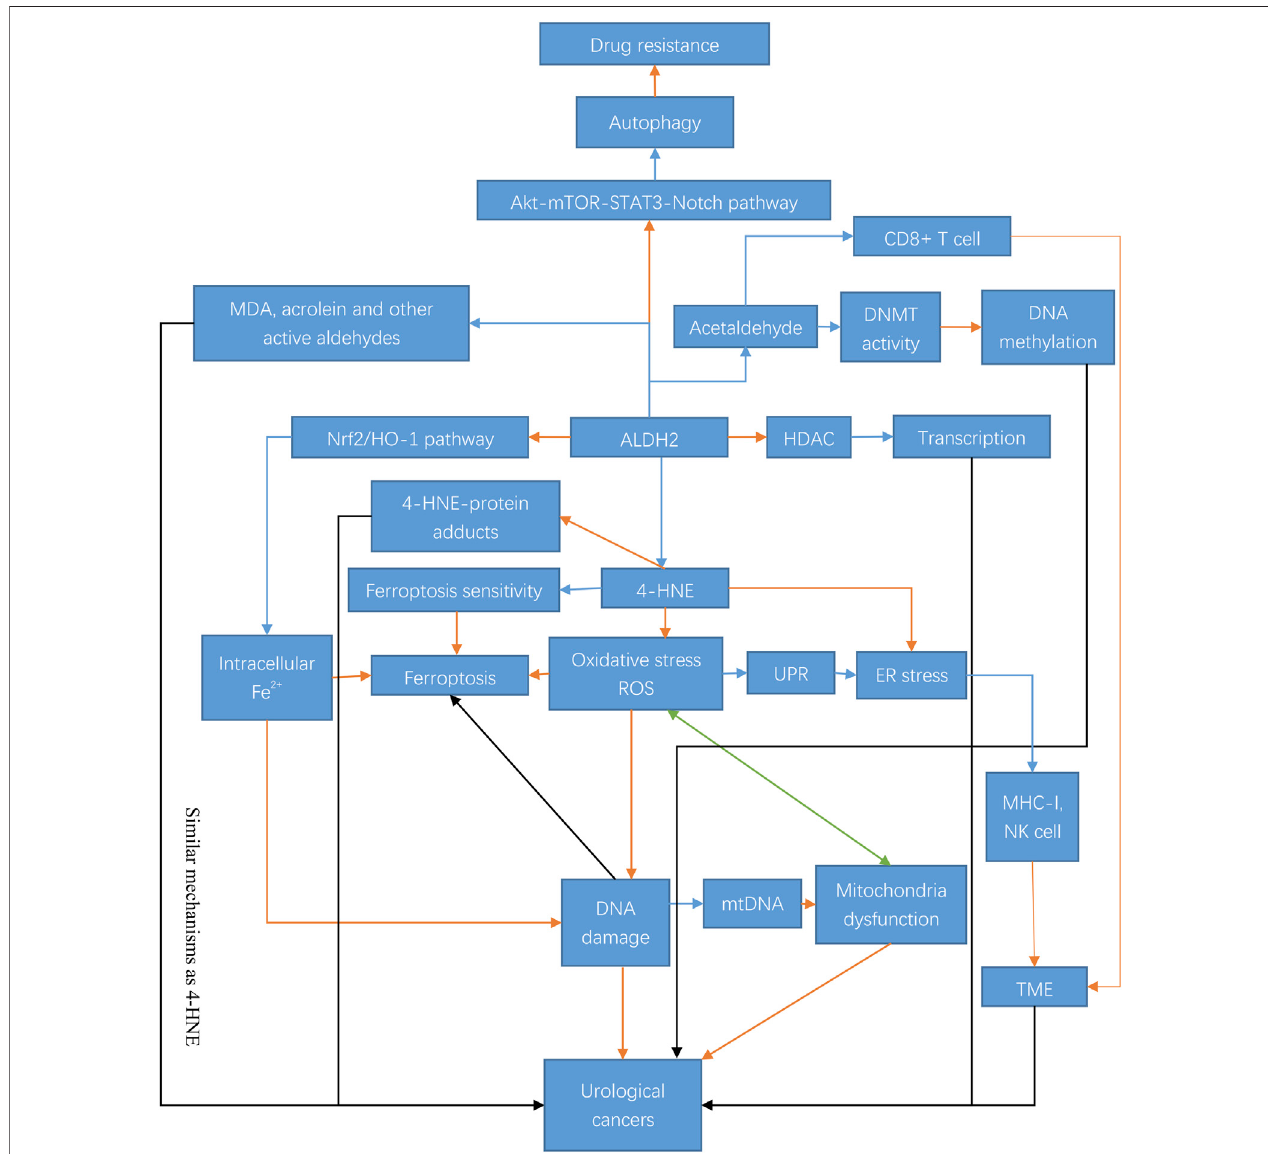
FIGURE 2 | Mechanisms and regulation of ALDH2 in urological cancer tumorigenesis. ALDH2 exerts its antitumor effects in urological tumors through a variety of mechanisms. ALDH2 can play a regulatory role through epigenetic modi fi cations and some pathways, such as the Akt-Notch pathway, and it can also regulate the generationofitsmetabolites,including4-HNE,MDA,andacrolein,andplayanantitumorrolethroughferroptosis,oxidativestress,autophagyandmanyotherpathways. The blue arrow indicates inhibition; the orange arrow indicates activation; the black arrow indicates both activation and inhibition; and the green arrow indicates mutual interaction. Abbreviations: STAT3, signal transducer and activator of transcription-3; mTOR, mammalian target of rapamycin; DNMT, DNA methyltransferase; HO-1,hemeoxygenase;HDAC,histonedeacetylase;ROS,reactiveoxygenspecies; UPR,unfoldedprotein response; ERstress,endoplasmic reticulumstress;MHC-I, major histocompatibility complex-I; mtDNA, mitochondrial DNA; TME, tumor microenvironment.